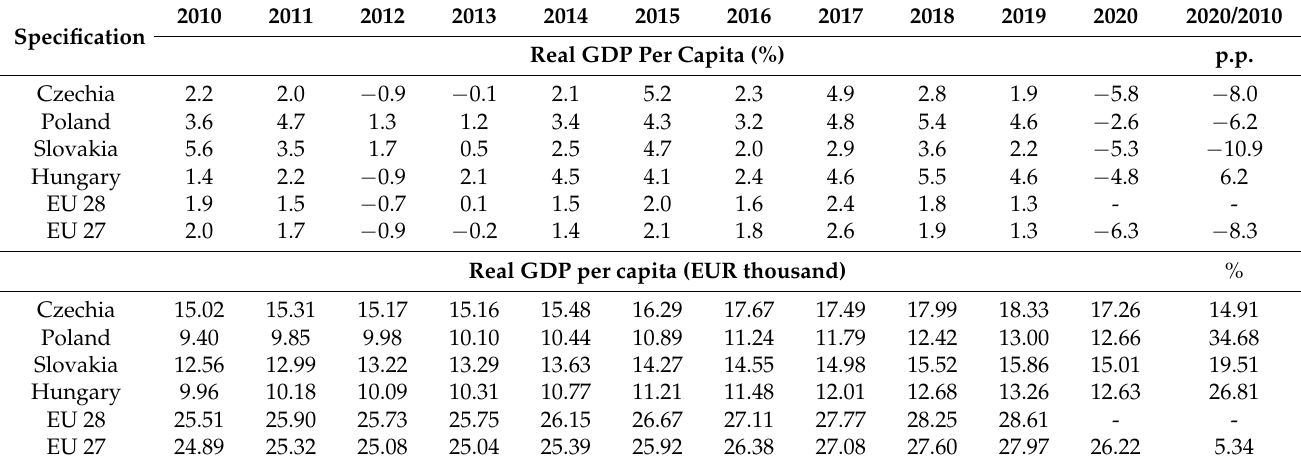
Table 2. Real GDP per capita in the Visegrad Group countries